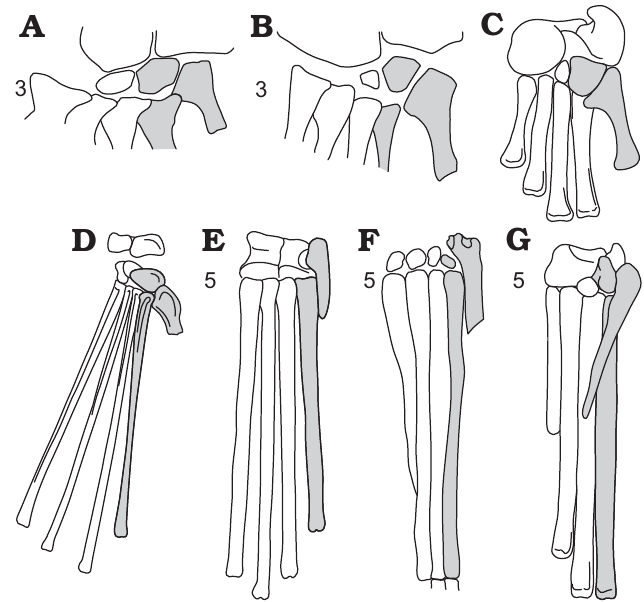
Fig. 7. Schematic relations between distal tarsals and metatarsals in Archo- sauriformes. A . Erythrosuchus , Erythrosuchidae, Early Triassic, Africa ( after Gower 1996). B . Euparkeria , Euparkeriidae, Middle Triassic South Africa (after Ewer 1965). C . Riojasuchus , Crurotarsi, Late Triassic South America (after Sereno 1991). D . Rham phorhynchus , Pterosauria, Late Jurassic, Europe, Africa (after Wellnhofer 1991). E . Pteranodon , Pterosauria, Late Cretaceous, North America (after Bennett 2001). F . Scleromochlus , Orni- thodira, Late Triassic, England (after Benton 1999). G . Marasuchus , Dino- sauriformes, Middle Triassic, South America (after Sereno and Arcucci 1994). Dorsal (A, B) and plantar (C, G) views. dTIV, MttIV and MttV shaded in grey. 3, saurian synapomorphy: neckless hooked MttV; 5, ornithodiran synapomorphy: MttV straight, reduced in size and importance. Not to